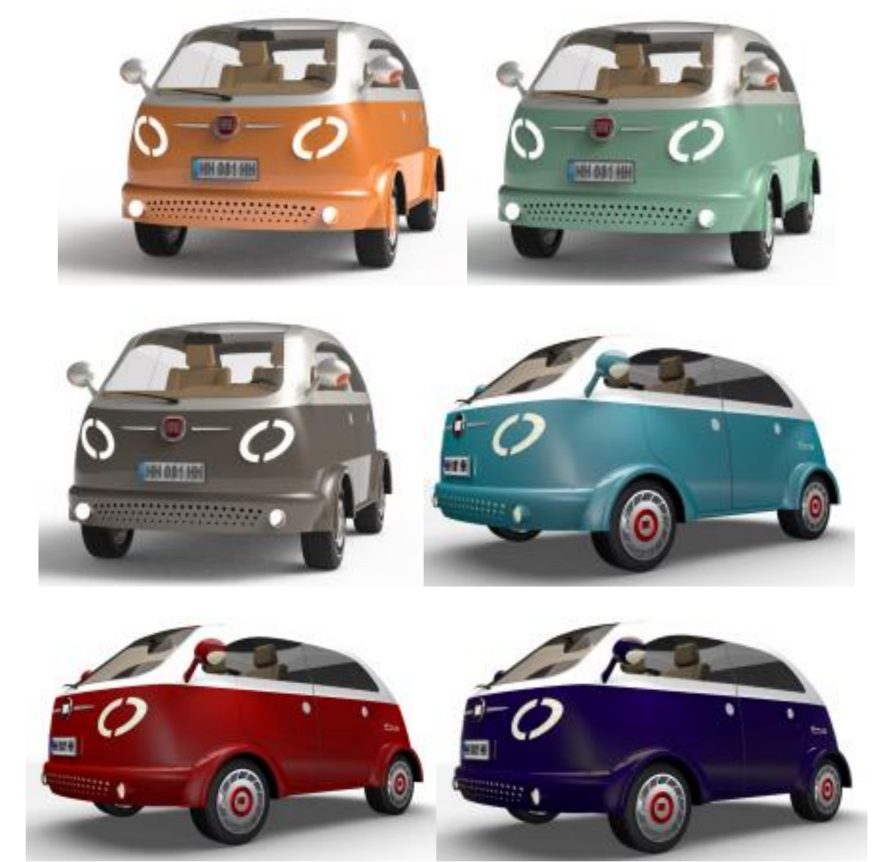
Figure 32. New FIAT 600